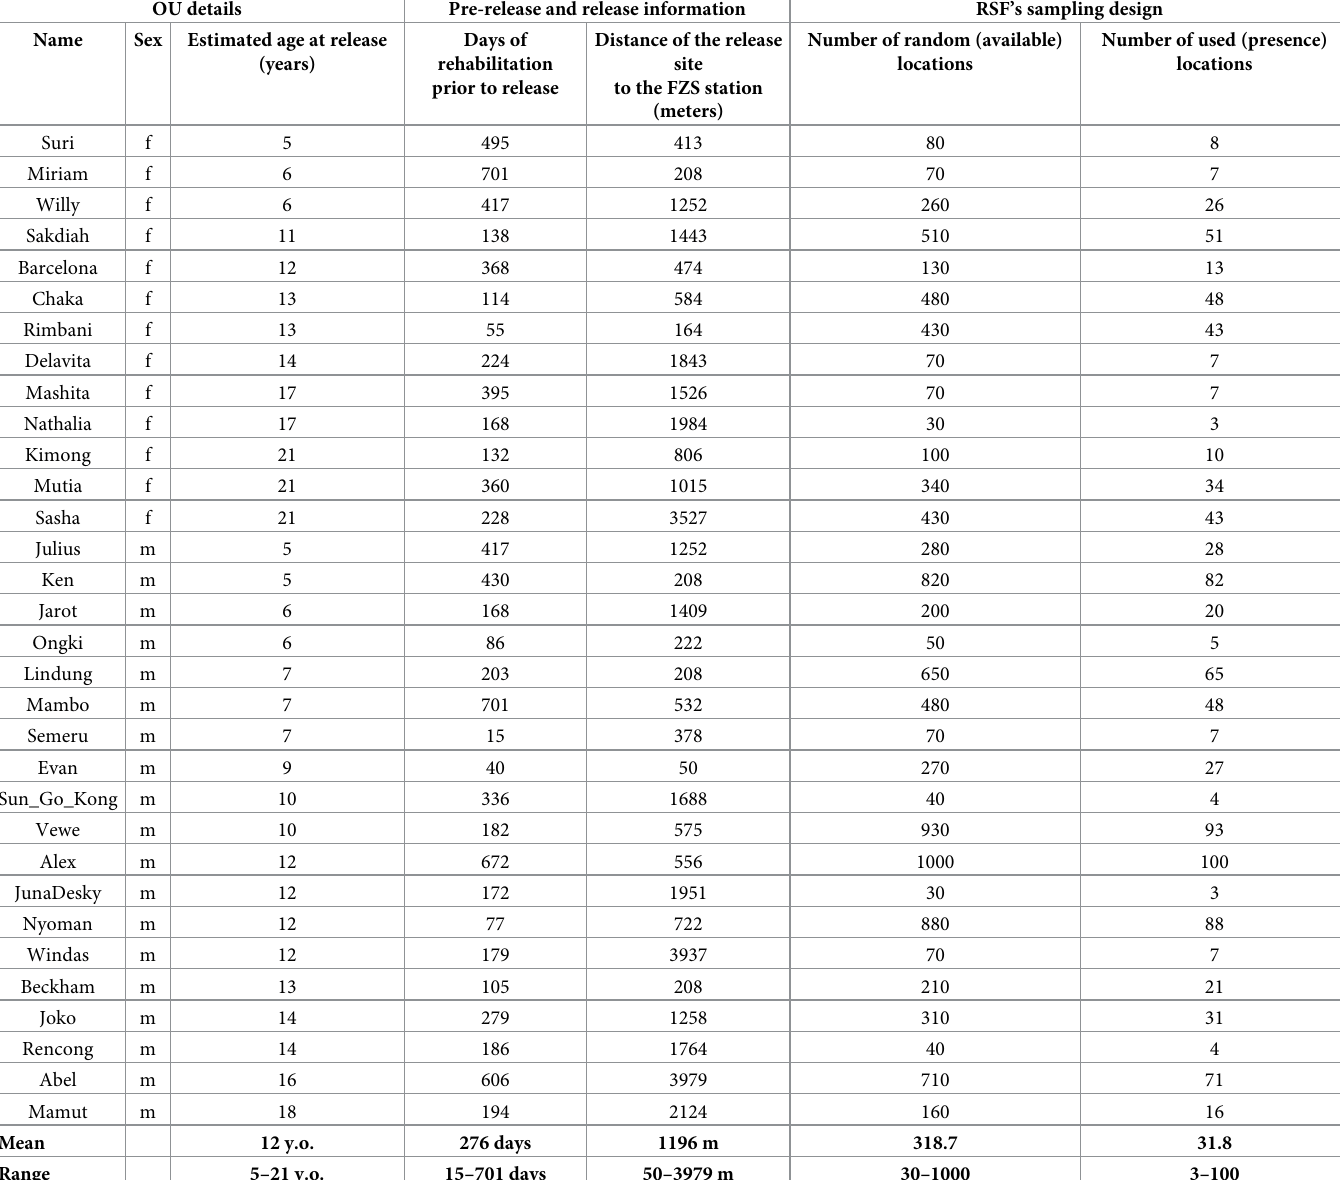
Table 1. Sex, estimated age at release, pre-release and release information on the 32 orangutans (OUs, 13 females, 19 males) released and monitored in central sumatra from 2011 to 2013 by means of very high frequency radio tracking. Individual spatial VHF relocations were used to build the population-level Resource Selec- tion Function (RSF), which estimates OUs’ resource selection in a presence-available design. ‘Used’ locations (i.e., presence) correspond to sites where OUs have been relo- cated, whereas ‘available’ locations are random points drawn within the population home range (kernel method, 99% isopleth), which define resource